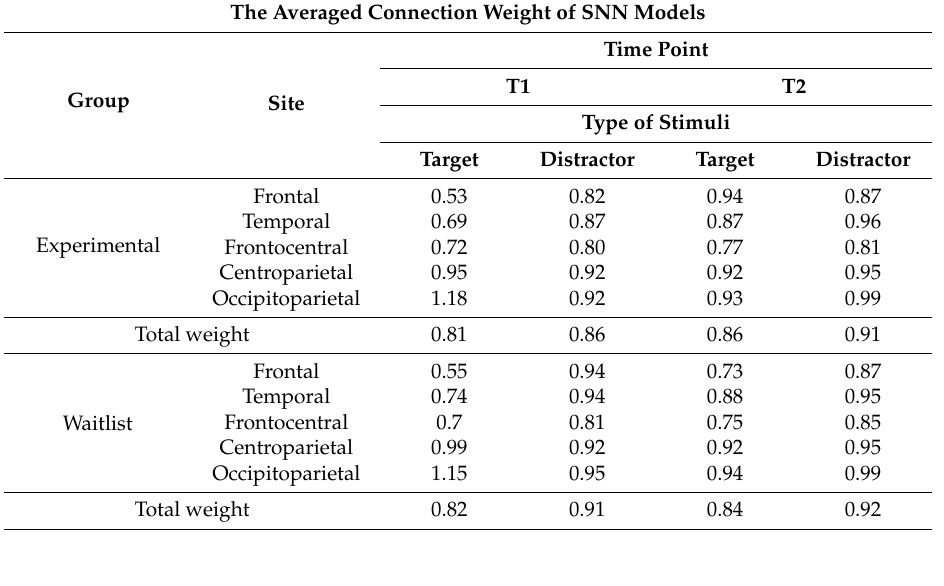
Table 1. The average connection weights measured for SNN models of target and distractor stimuli across five sites of the brain (frontal, temporal, frontocentral, centroparietal, and occipitoparietal) for both experimental and waitlist groups before training (T1) and after training (T2).